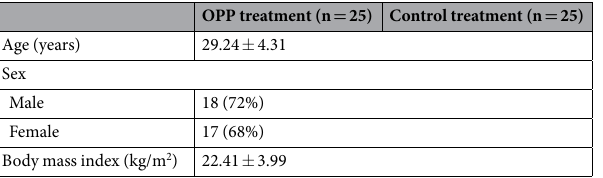
Table 1. Volunteers demographic characteristics. Data is tabulated as mean ± SD, or n